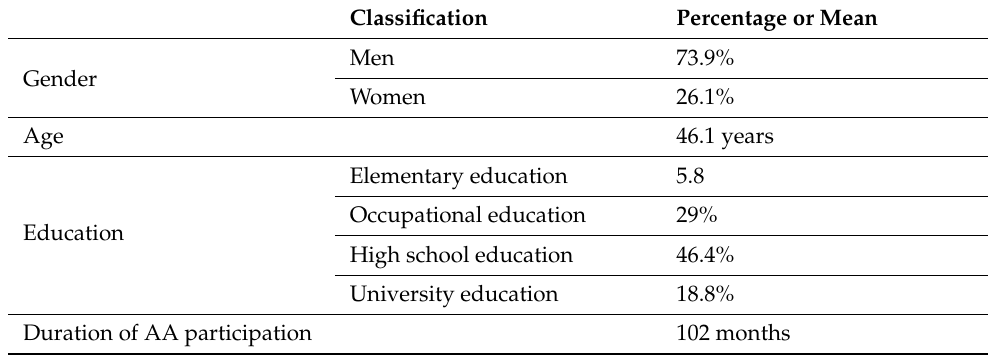
Table 1. Demographics variables ( n =